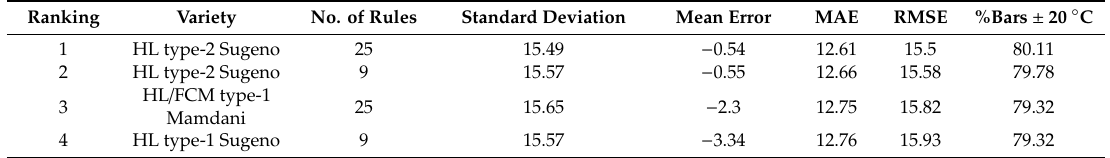
Figure 9. Scatter diagram of the 9-rule HL/FCM type-2 Sugeno GB model predicted scale breaker entry temperature.